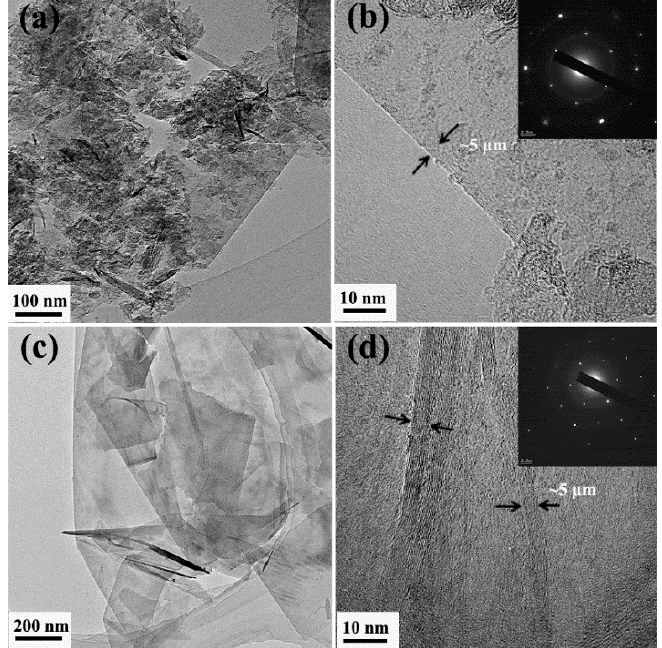
Figure 2. ( a ) TEM image of GnP-C750, ( b ) HRTEM image of GnP-C750, ( c ) TEM image of GnP-5, ( d ) HRTEM image of GnP-5 (insets: electron diffraction patterns). ( d ) HRTEM image of GnP-5 (insets: electron diffraction patterns).